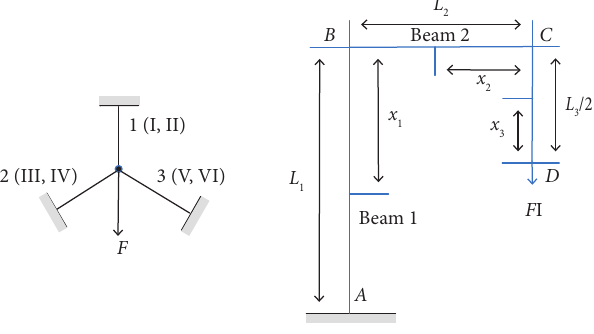
Figure 7. The definition and the force diagram. a) Load and definition of flexible unit; b) half of flexible unit I.